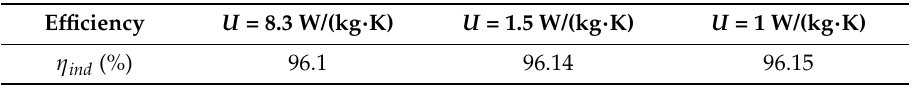
Table 8. Efficiency system for the second configuration varying the transmittance of the tank.